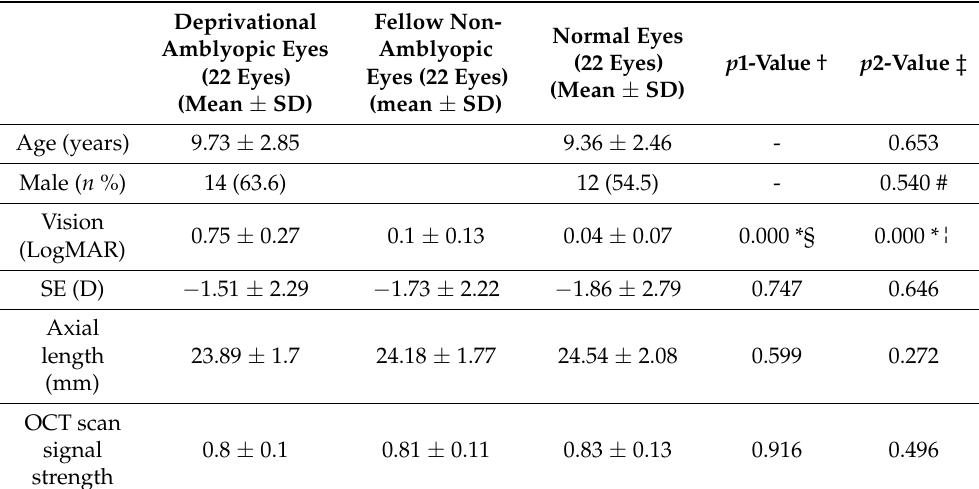
Table 1. Demographic and clinical description of patients with deprivational ambylopia and children from control group.